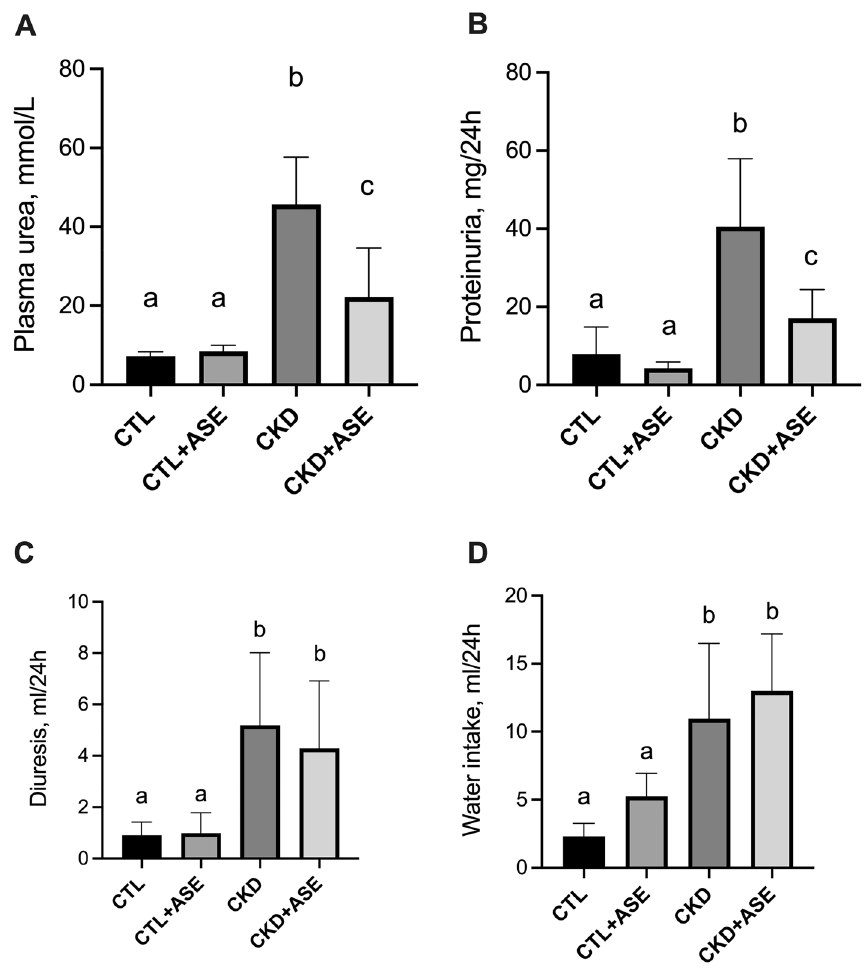
Figure 3. Evaluation of renal function in experimental mice. Plasma concentration of urea ( A ), daily proteinuria ( B ), 24 h-diuresis ( C ) and daily water intake ( D ). Data are expressed as means ± SD (n = 9–10 for each group). Significant differences were determined by two-way ANOVA followed by Tukey’s multiple comparison test. Different letters indicate a significant difference between groups at the P < 0.05 level.